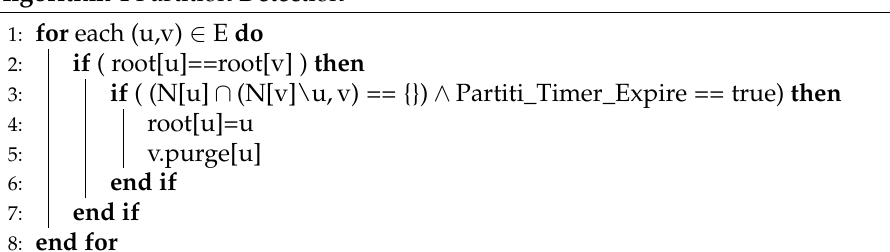
Algorithm 4 Partition